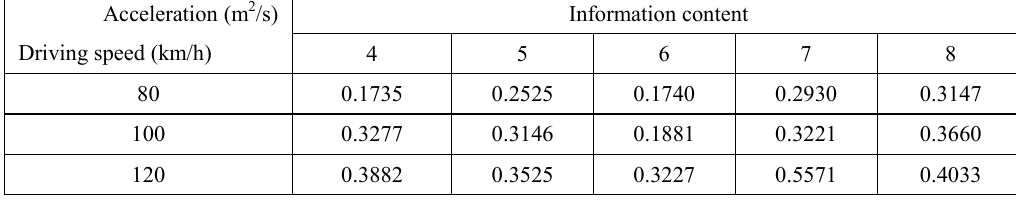
Table 4 Driving offset on different information content with changed